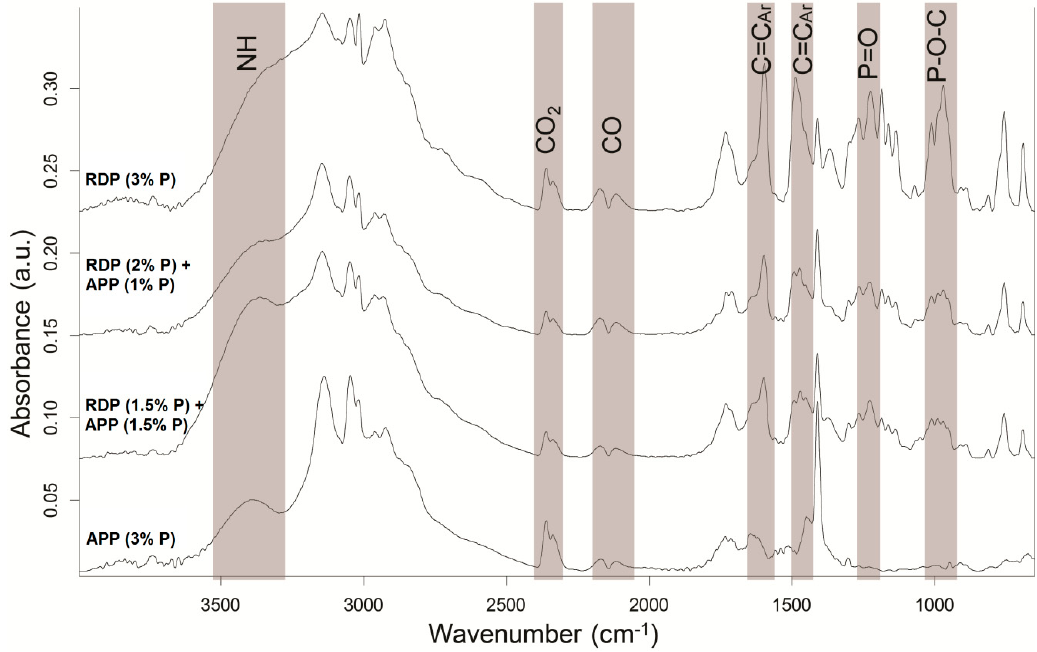
Figure 6. Laser pyrolysis–Fourier transform infrared (LP-FTIR) spectra of the gas phase degradation products from 3% P-containing samples.